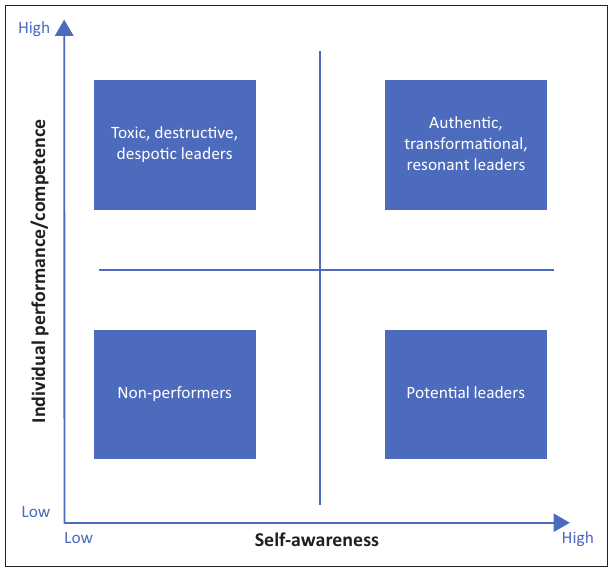
HighLowLowHigh Authen(cid:18)c, Toxic, destruc(cid:18)ve, transforma(cid:18)onal, despo(cid:18)c leaders resonant Non-performers Poten(cid:18)al leaders Self-awareness FIGURE 5: Model prediction for leadership potential based on individual performance by self-awareness adapted from Cuddy et al. (2011).